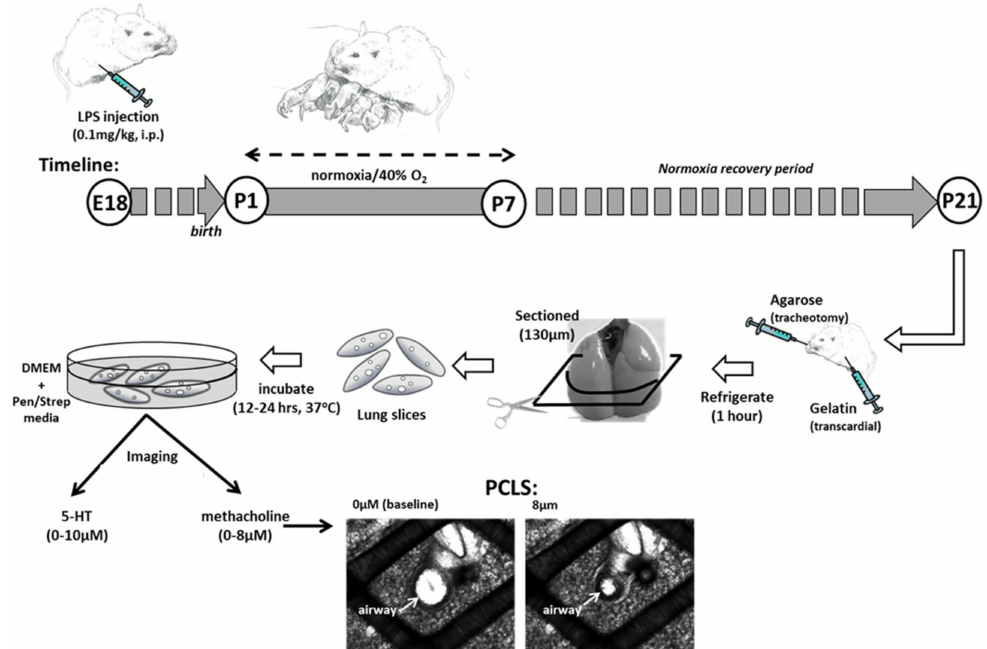
Figure 1. Mouse Model of Perinatal Inflammation and Hyperoxia Exposure. Pregnant dams received an i.p. injection of saline or lipopolysaccharide (LPS) on embryonic day 18 (E18). On postanatal day 1 (P1), pups were exposed to normoxia (21% O 2 ) or mild hyperoxia (40% O 2 ) for 7 days. All litters were returned to room air until 21 days of age. Precision-cut living lung slices (PCLS) were prepared and airway responses to methacholine challenge (shown) or vessel responses to serotonin challenge were recorded under video